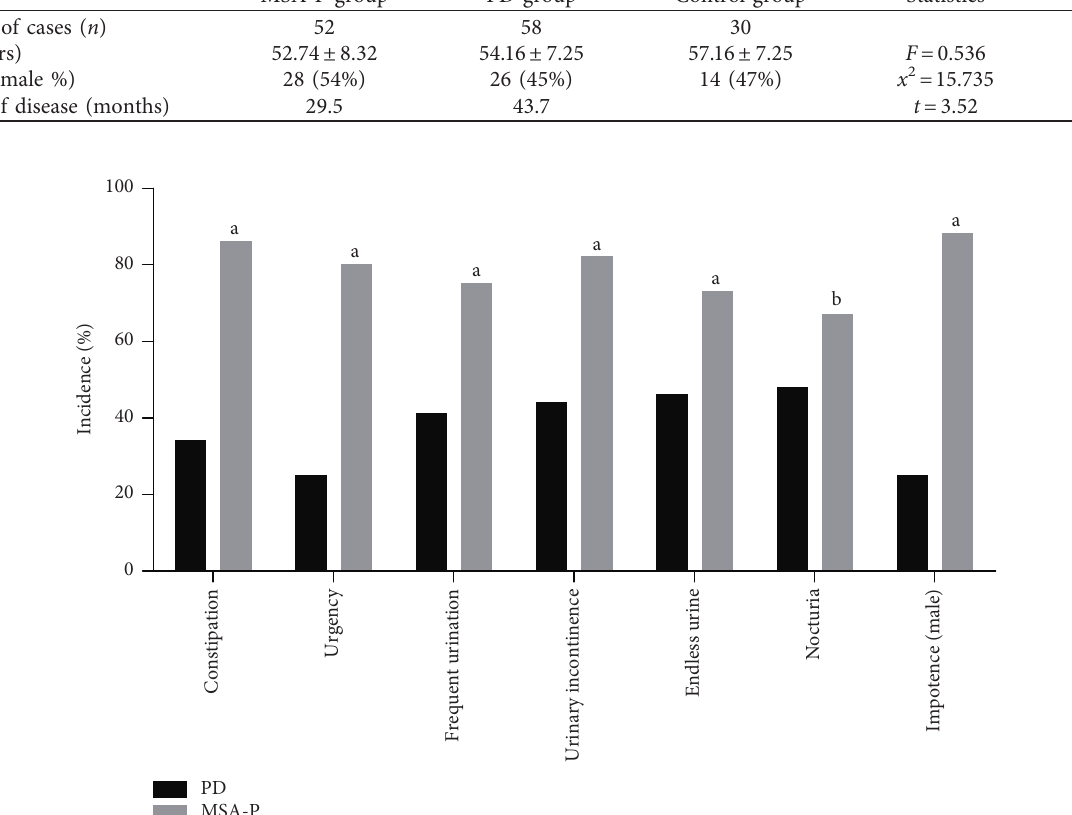
Figure 1: The incidence of sacral reflex dysfunction in the MSA-P group and PD group. a p < 0 . 05 compared to PD. b p > 0 . 05 compared to PD.